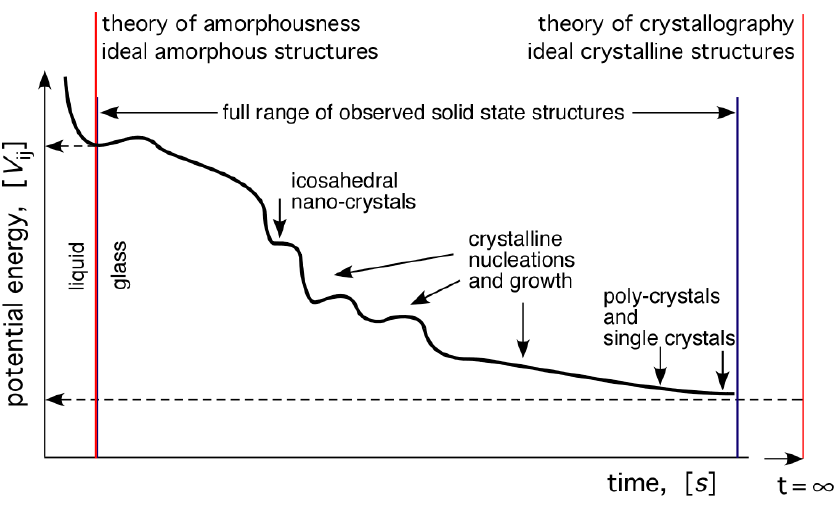
Figure 11. Schematic representation all possible atomic arrangement structures that may occur in a system cooled from liquid to solid. Note the two theories superimposed in the figure; the theory of crystallography, and a developing theory of